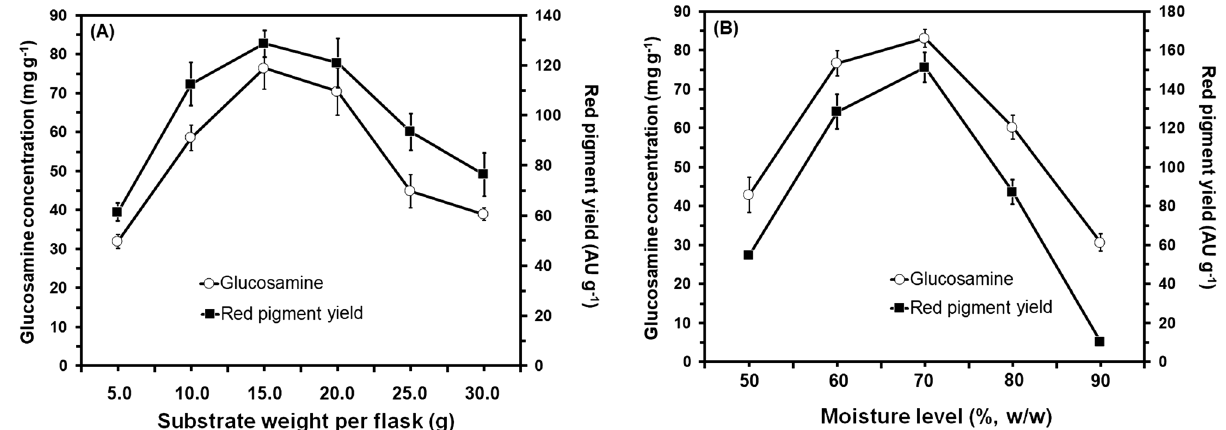
Figure 5. Effect of different weights of potato peel as substrate (A) and effect of different moisture levels (B) on growth (mg g −1 ) and red pigments production (AU g −1 ) by Monascus ruber SRZ112 under SSF. Initial pH of the MSB moistening agent was adjusted to 6.0 using 1 N NaOH and HCl. Solid–state grown cultures were carried out on potato peel at 30 °C for 10 days. All data are shown as the mean ± SD of triplicate measurements from two independent experiments.